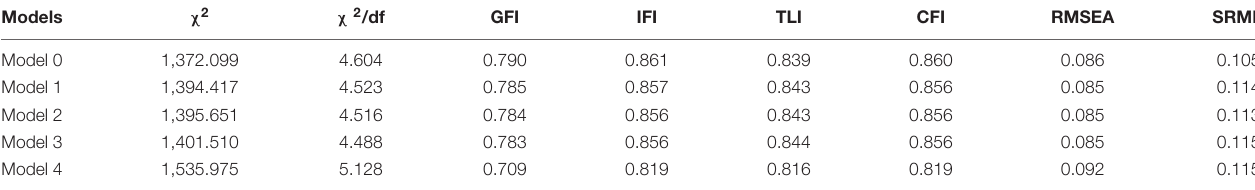
TABLE 7 | Models fit.